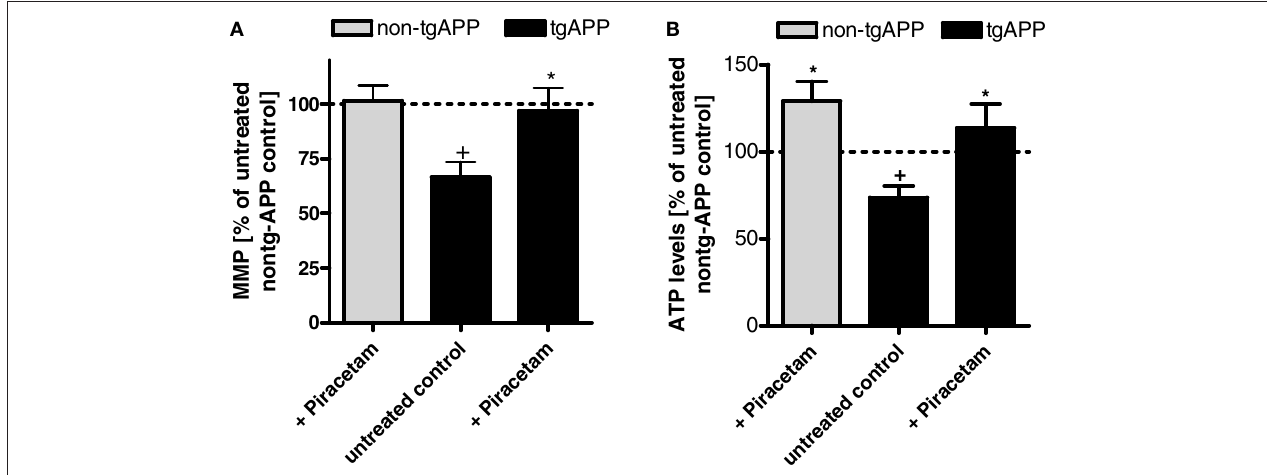
Figure 2 | Piracetam improves measures of mitochondrial function in tgAPP mice. (A) Animals were treated for 14 days with 0.5 g piracetam/kg in 0.9% NaCI solution p.o. once daily for 2 weeks. Control animals received 0.9% NaCI solution alone. All data are modified after Kurz et al. (2010). The MMP was significantly reduced in tgAPP mice. Piracetam treatment normalizes the MMP to non-tgAPP levels. Data are expressed as mean ± SEM ( n = 7–8). + p < 0.05 control non-tgAPP vs. control tgAPP, * p < 0.01 piracetam treated